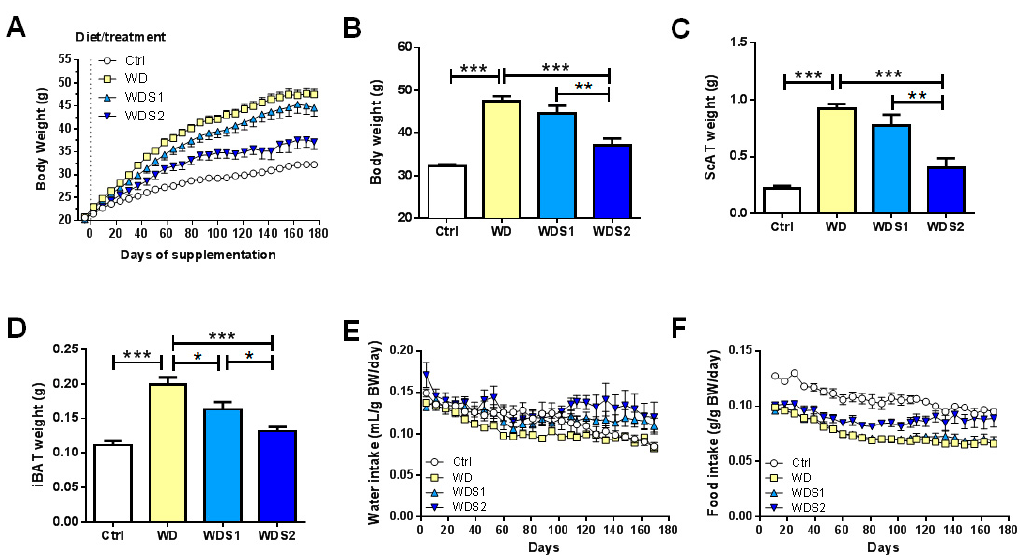
Figure 1. Spirulina liquid extract protects against diet induced obesity and increases food intake. ( A ) Follow up of body weight over 25 weeks and ( B ) final body weight. ( C ) Subcutaneous adipose tissue (ScAT) and ( D ) interscapular brown adipose tissue (iBAT) weight at the end of the supplementation. ( E ) Follow up of water intake and ( F ) food intake calculated as water or food intake-to-body weight ratio for each mouse and every week. * p < 0.05, ** p < 0.01, *** p < 0.001 ( n = 9–10/group), ANOVA.